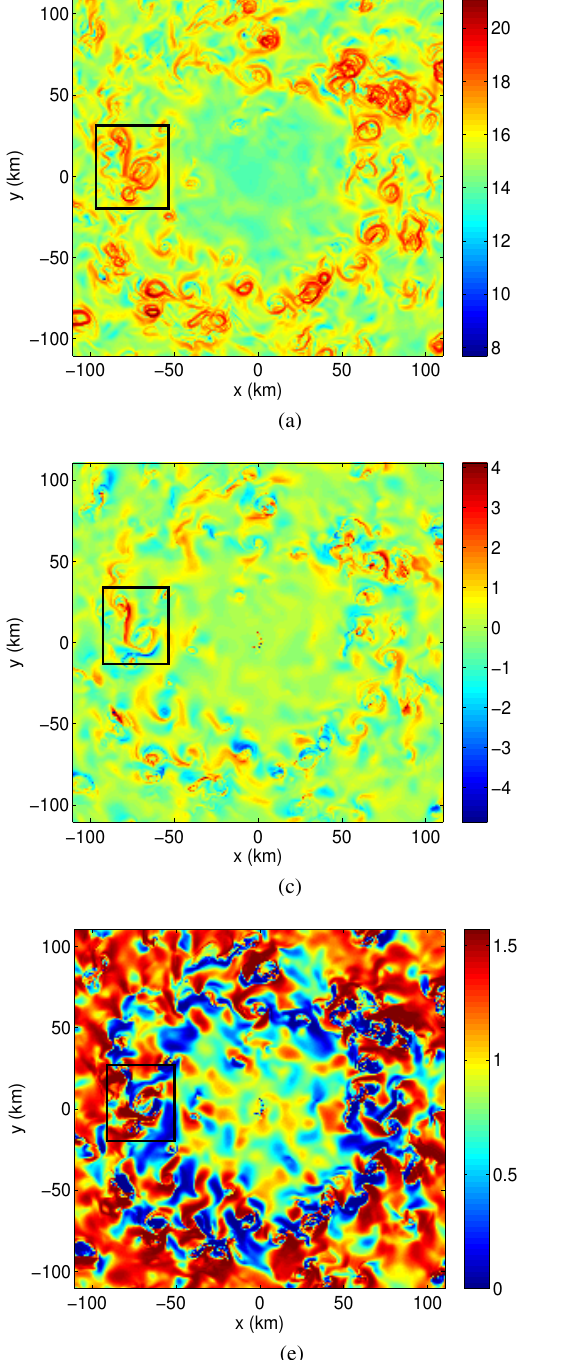
faster than the 3-D FTLE field. In contrast, the 9 fields are computed using the full 3-D trajectories, and the horizontal